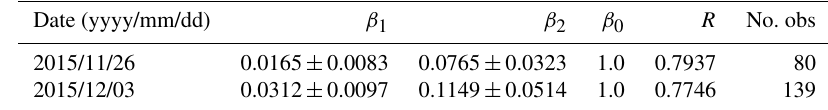
Table 3. Coefficients of the multiple linear regression and the correlation coefficient ( R ) for the measured and modeled HCHO in Eq. (15). β 1 represents the emission ratio of HCHO with respect to CO. β 2 denotes the portion of HCHO from photochemical production, while β 0 represents HCHO background concentration which is fixed to 1ppbv.